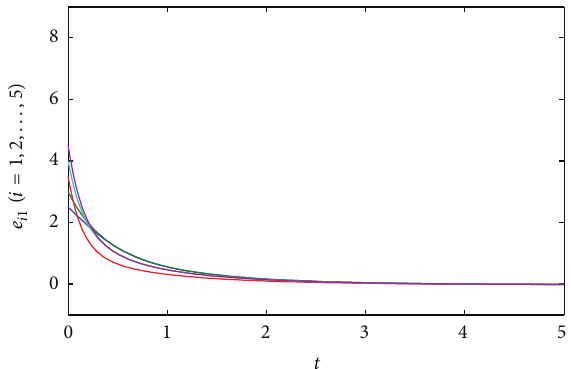
Figure 1: The position each agent during the movement. Each agent node interacts at a given time with only those agents located within a neighborhood of an interaction radius. Here, we let periodic boundary conditions size 𝐿 = 60 . The initial position 𝑦 𝑖 (0) of agent 𝑖 in the plane is chosen at random. The initial orientation 𝜃 𝑖 (0) = 0 , other time units being chosen at each time unit with uniform probability in the interval [0, 2𝜋] . Each agent is moving 40 time unit ( 𝑇 = 40 ). Then the position of each agent during the movement is shown in Figure 1.